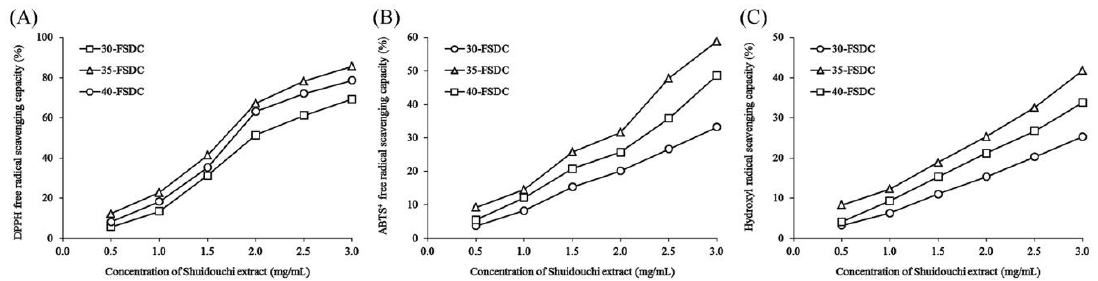
Figure 3. Soybean isoflavone contents of Shuidouchi fermented at different temperatures. a–c Mean values with different letters indicate significant differences ( p <0.05). US: unfermented soybean; 30-FSDC (fermented Shuidouchi): 30 °C fermented Shuidouchi; 35-FSDC: 35 °C fermented Shuidouchi; 40-FSDC: 40 °C fermented Shuidouchi.